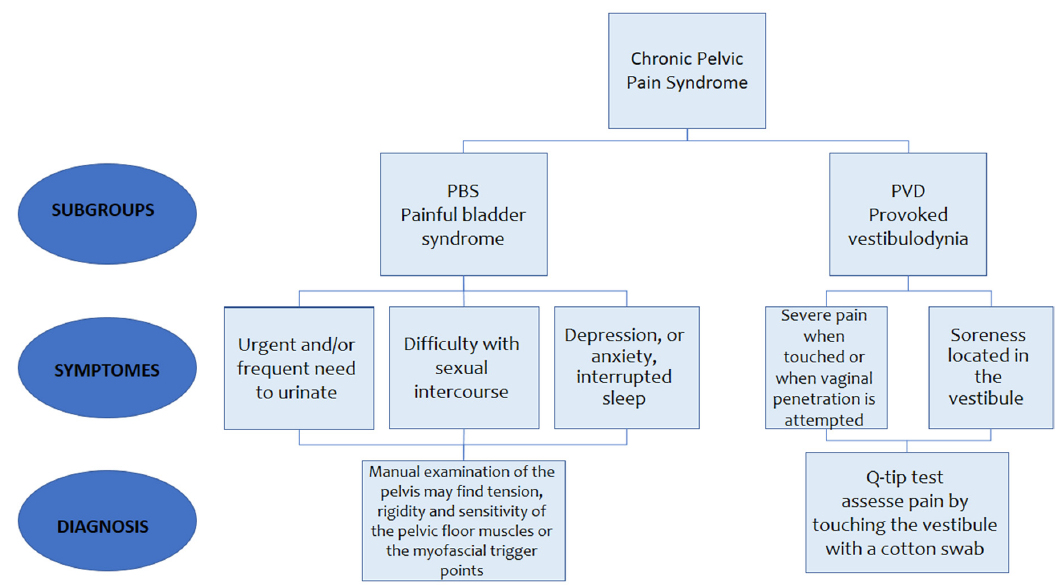
Figure 1. Symptoms and diagnosis of subgroups of chronic pelvic pain syndrome (CPPS).